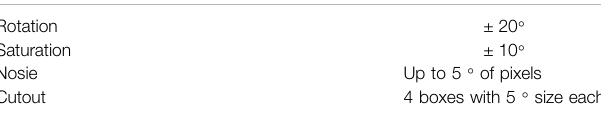
TABLE 2 | Data augmentation methods.